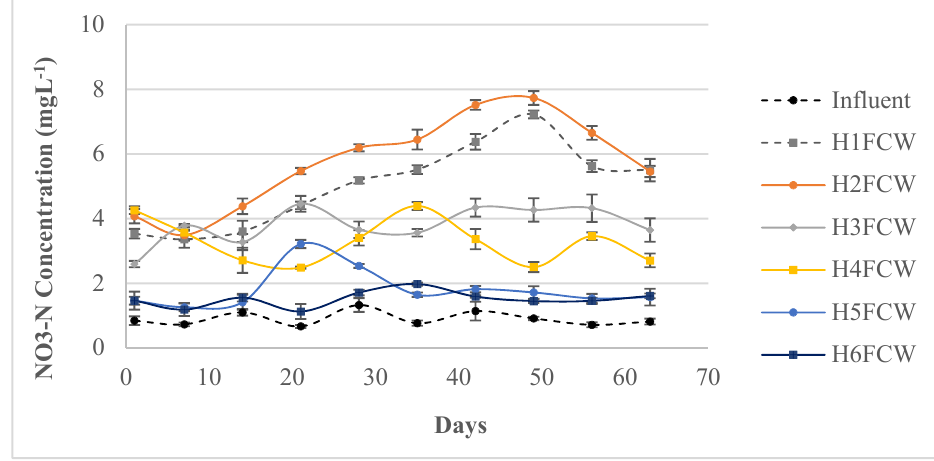
Figure 5. Nitrogen concentration in different mesocosm HFCWs (HRT = 48 h).